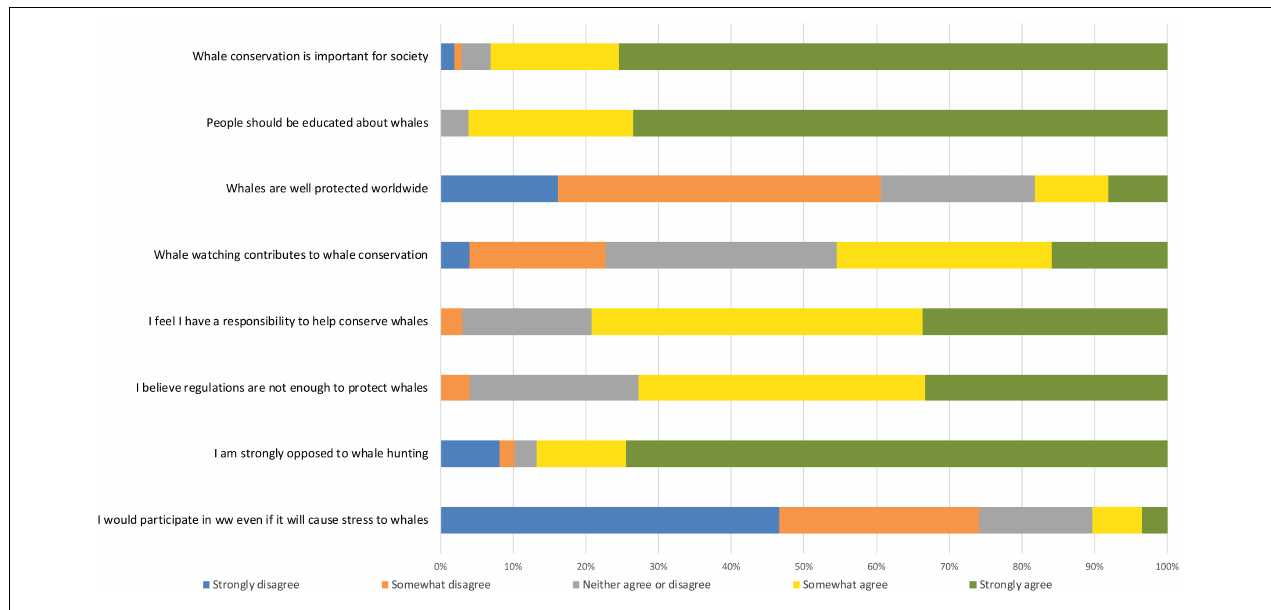
FIGURE 4 | Level of agreement with statements about whale